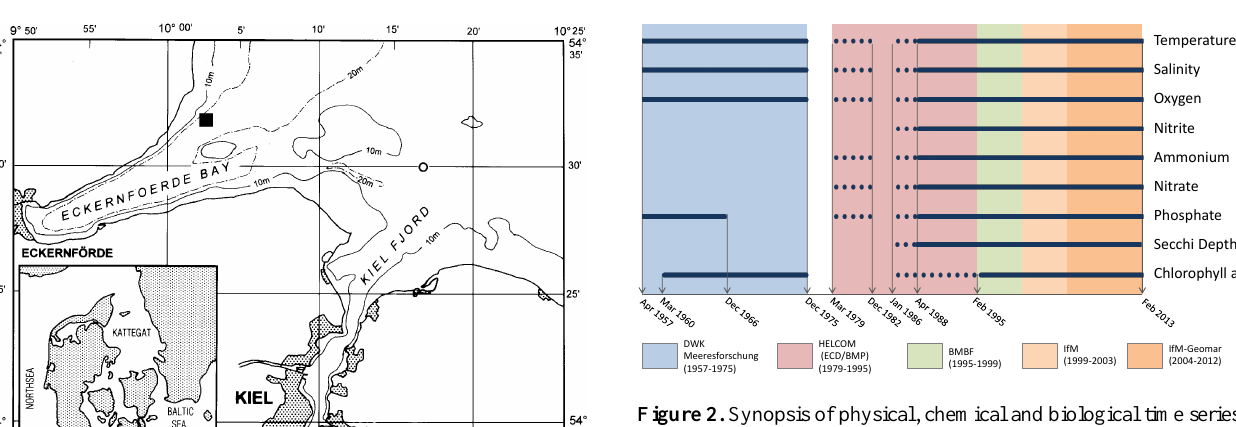
Figure 2. Synopsis of physical, chemical and biological time series at Boknis Eck. Solid lines indicate regular monthly measurements with only up to two following months missing (rare), dotted lines indicate only very irregular measurements with large gaps. Colors represent financial support by different funders. DWK = Deutsche Wissenschaftliche Kommission, HELCOM = Helsinki Commission, BMBF = Bundesministerium für Bildung und Forschung, IfM = Institut für Meereswissenschaften.